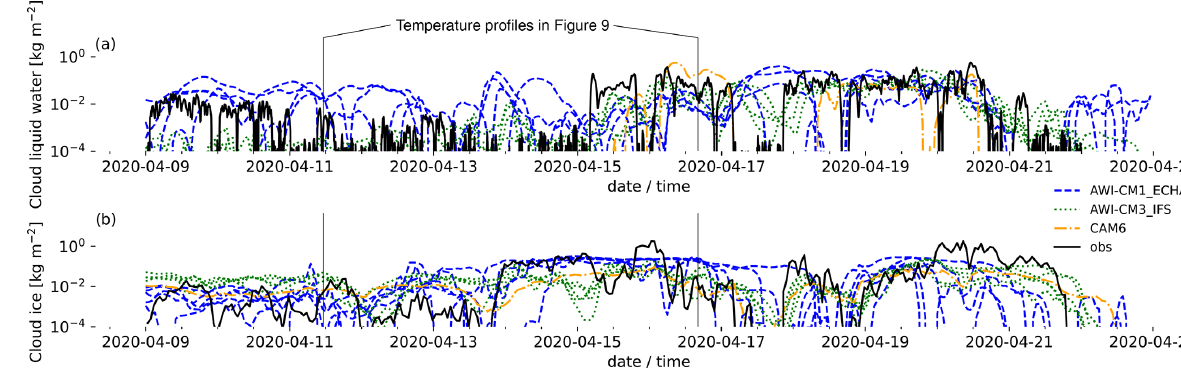
Figure 5. Observed and modelled liquid and ice water path for the period 9 to 23 April 2020.